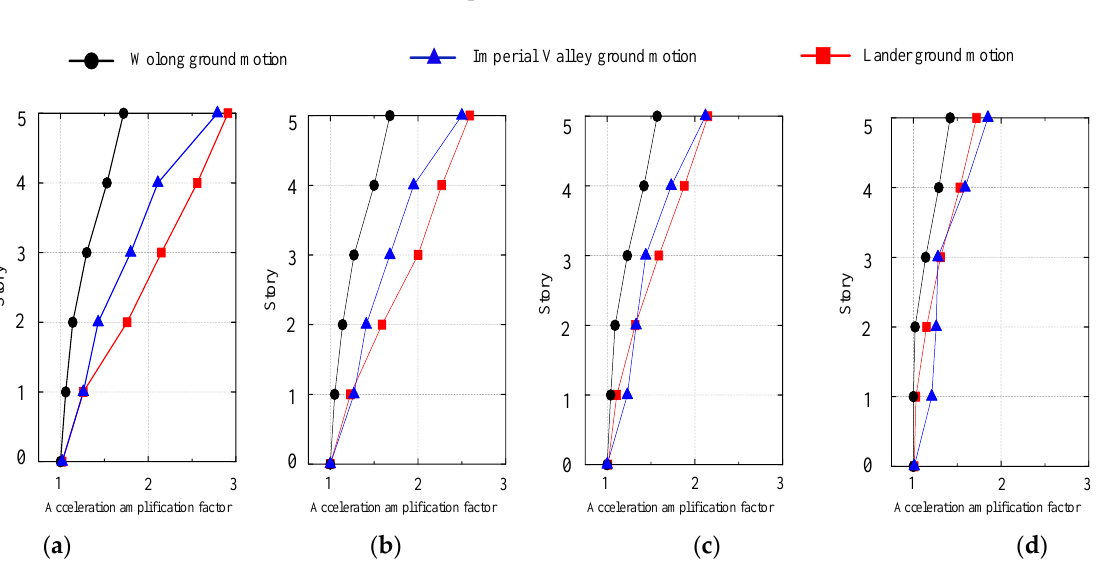
Figure 10. Acceleration amplification factor of the structure under different seismic intensities. ( a ) PGA = 0.1 g, ( b ) PGA = 0.22 g, ( c ) PGA = 0.4 g, ( d ) PGA = 0.62 g.